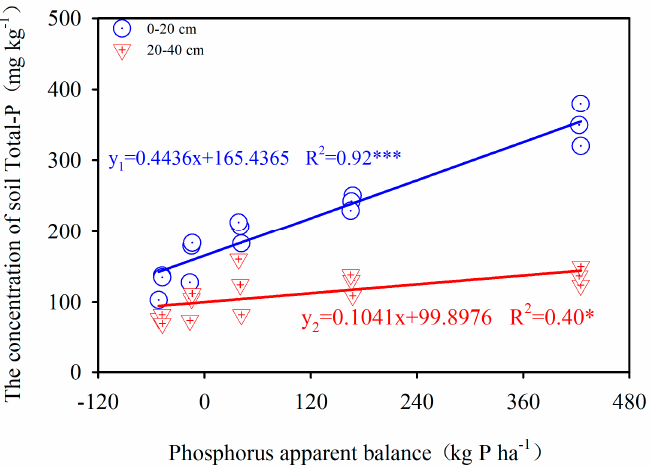
Figure 3. Relationship between PAB and total P come from the field experiment. Note: * means p < 0.05, *** means p < 0.001. *** means p <